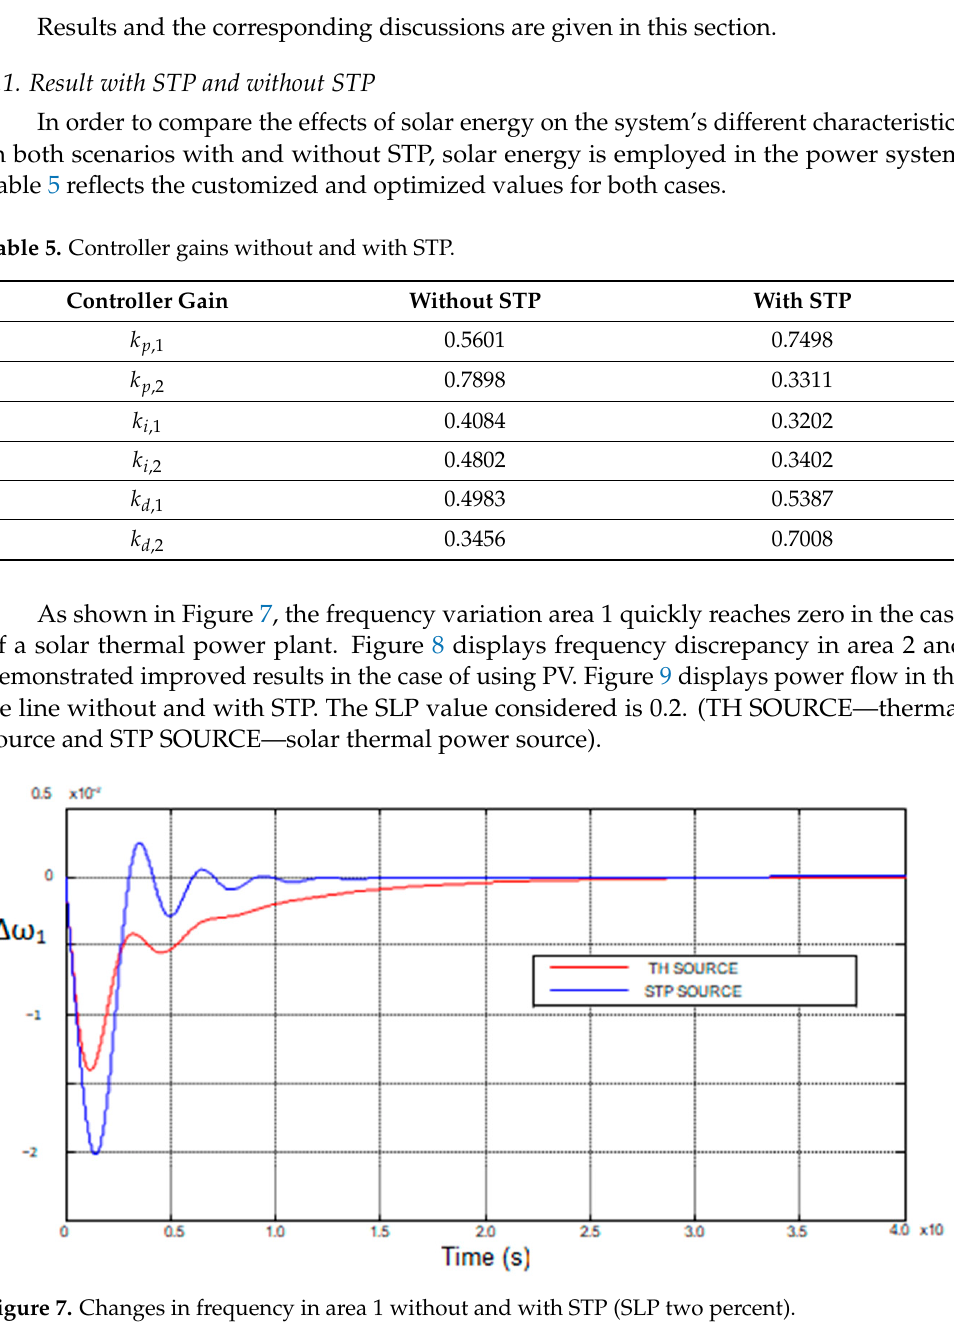
Figure 8. Changes in frequency in area 2 without and with STP (SLP two percent). Figure 9. Power flow in tie line without and with STP (SLP two percent).